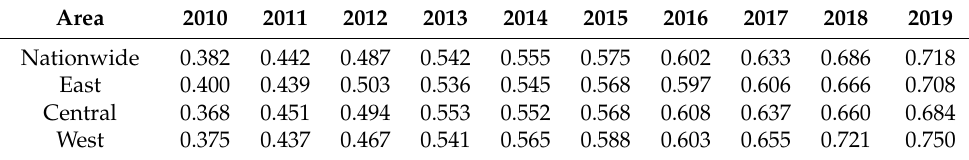
Table 3. Mean value of coordination degree of PREE system in various regions of